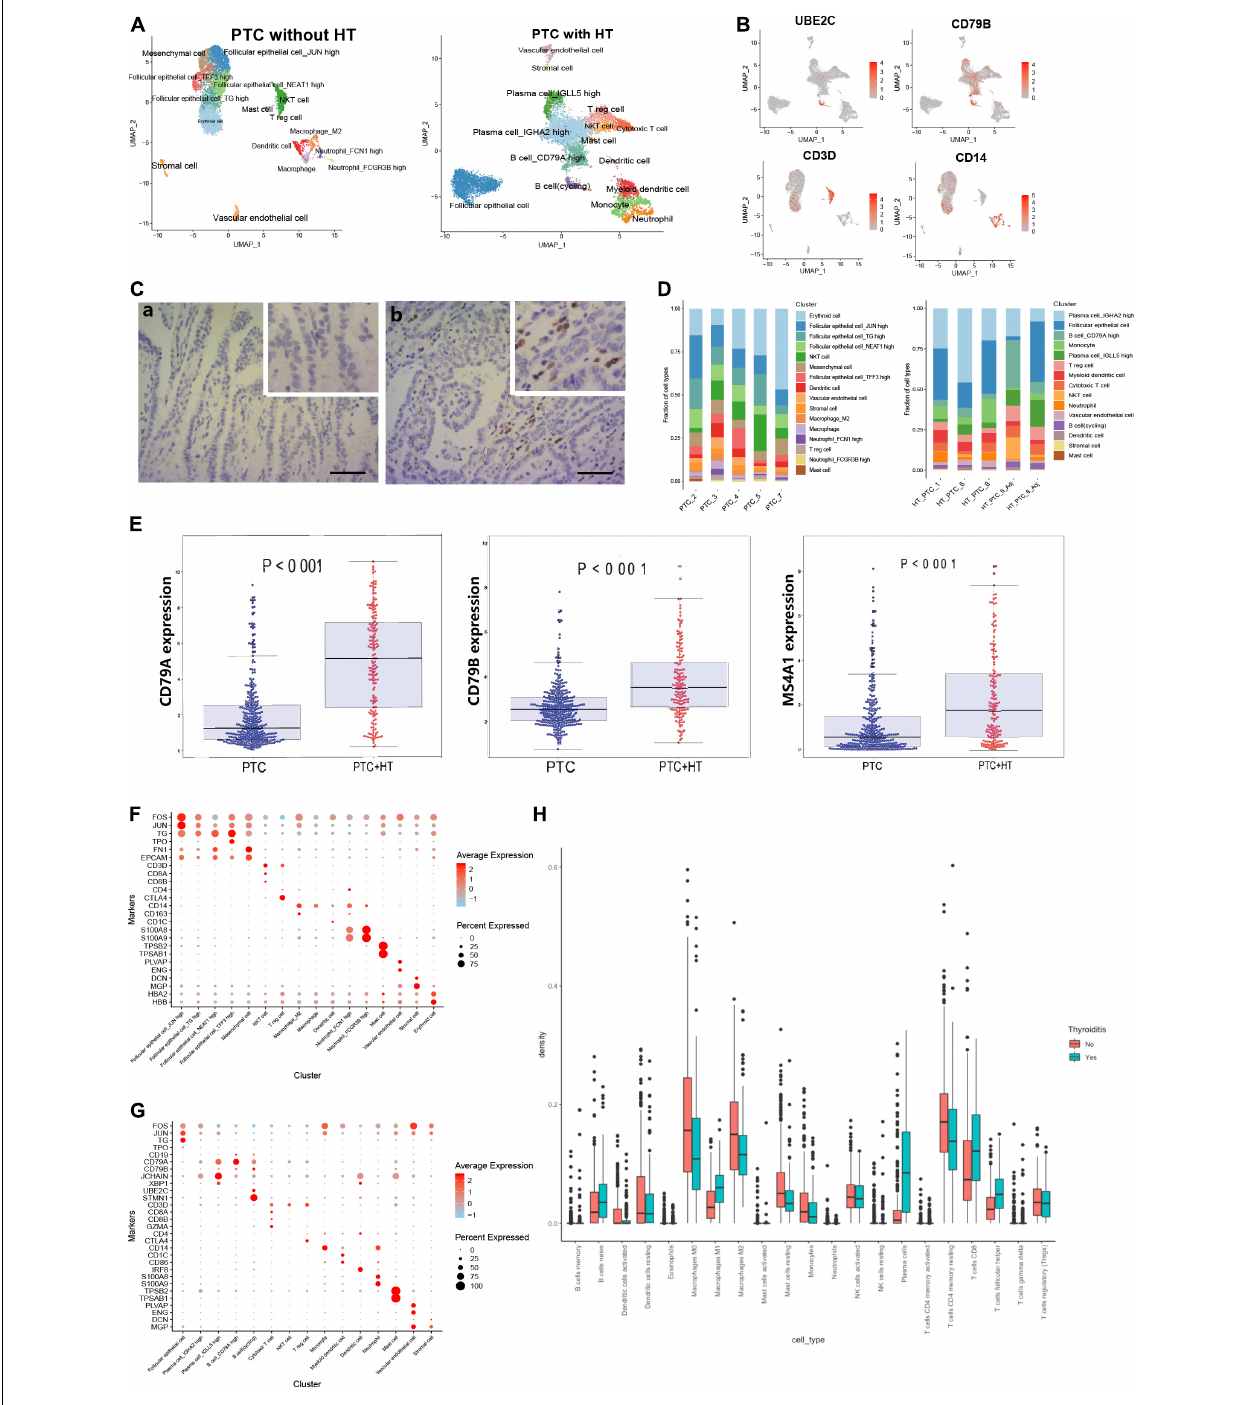
FIGURE 5 | Reclustering of single cells in samples from two types of PTC. (A) UMAP plot of single cells in samples from two types of PTC. (B) FeaturePlot of selected marker genes in two types of PTC. (C) Immunostaining of CD79A/B in two types of samples from PTC patients. Positive signals were stained in brown. Scale bar = 50 µ m. (a: sample from PTC patient without concurrent HT, b: sample from PTC patient with concurrent HT). (D) The fractions of cell types in samples from two types of PTC. (E) The expression levels of B cell marker genes in the TCGA-THCA cohort based on PTC types. PTC, PTC patients without concurrent HT; PTC + HT, PTC patients with concurrent HT. (F) Dot plot of marker genes in samples from PTC patients without concurrent HT. Average expression is color-coded. Columns represent the selected marker genes. (G) Dot plot of marker genes in samples from PTC patients with concurrent HT. Average expression is color-coded. Columns represent the selected marker genes. (H) Density of canonical immune cells in the TCGA-THCA cohort. Thyroiditis Yes, PTC patients with concurrent HT; Thyroiditis No, PTC patients without concurrent HT.